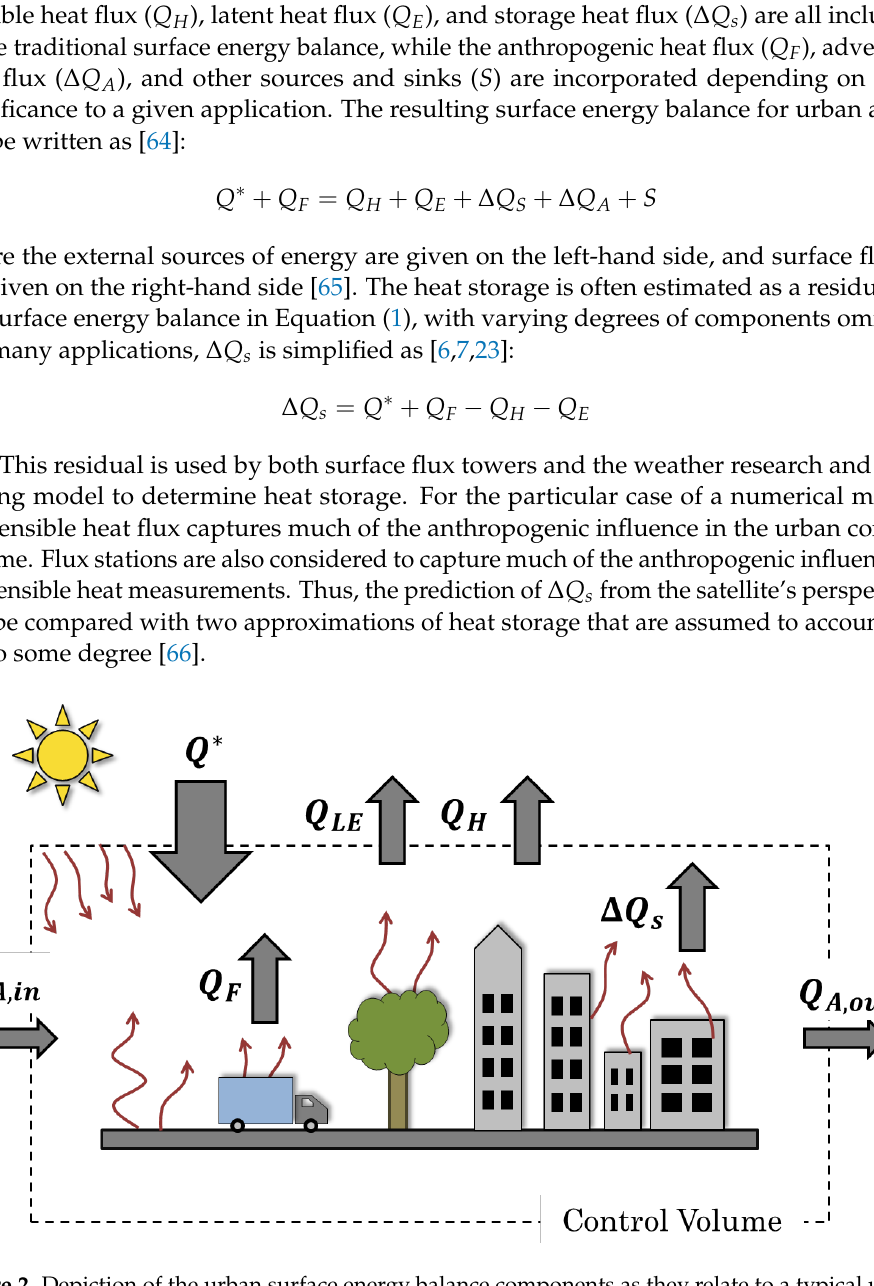
Figure 2. Depiction of the urban surface energy balance components as they relate to a typical urban control